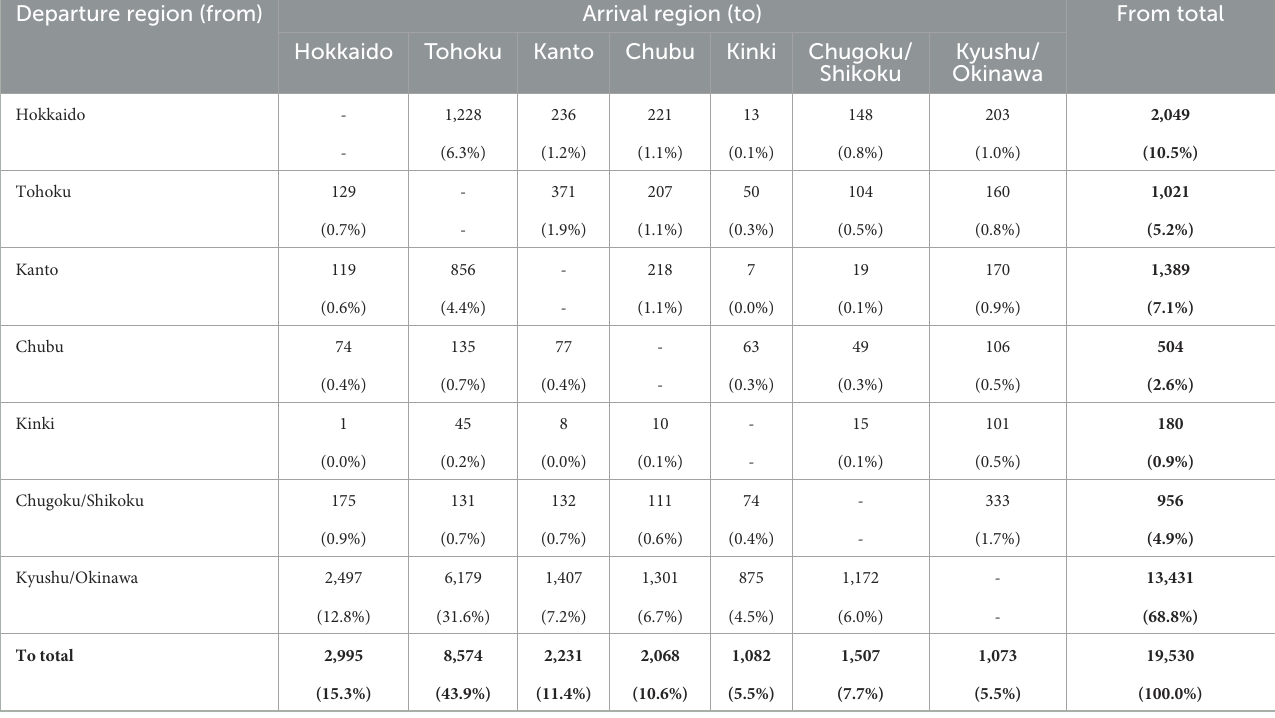
TABLE 3 The number of inter-regional movements of beef cows from 8 to 11 months old. Departure region (from) Arrival region